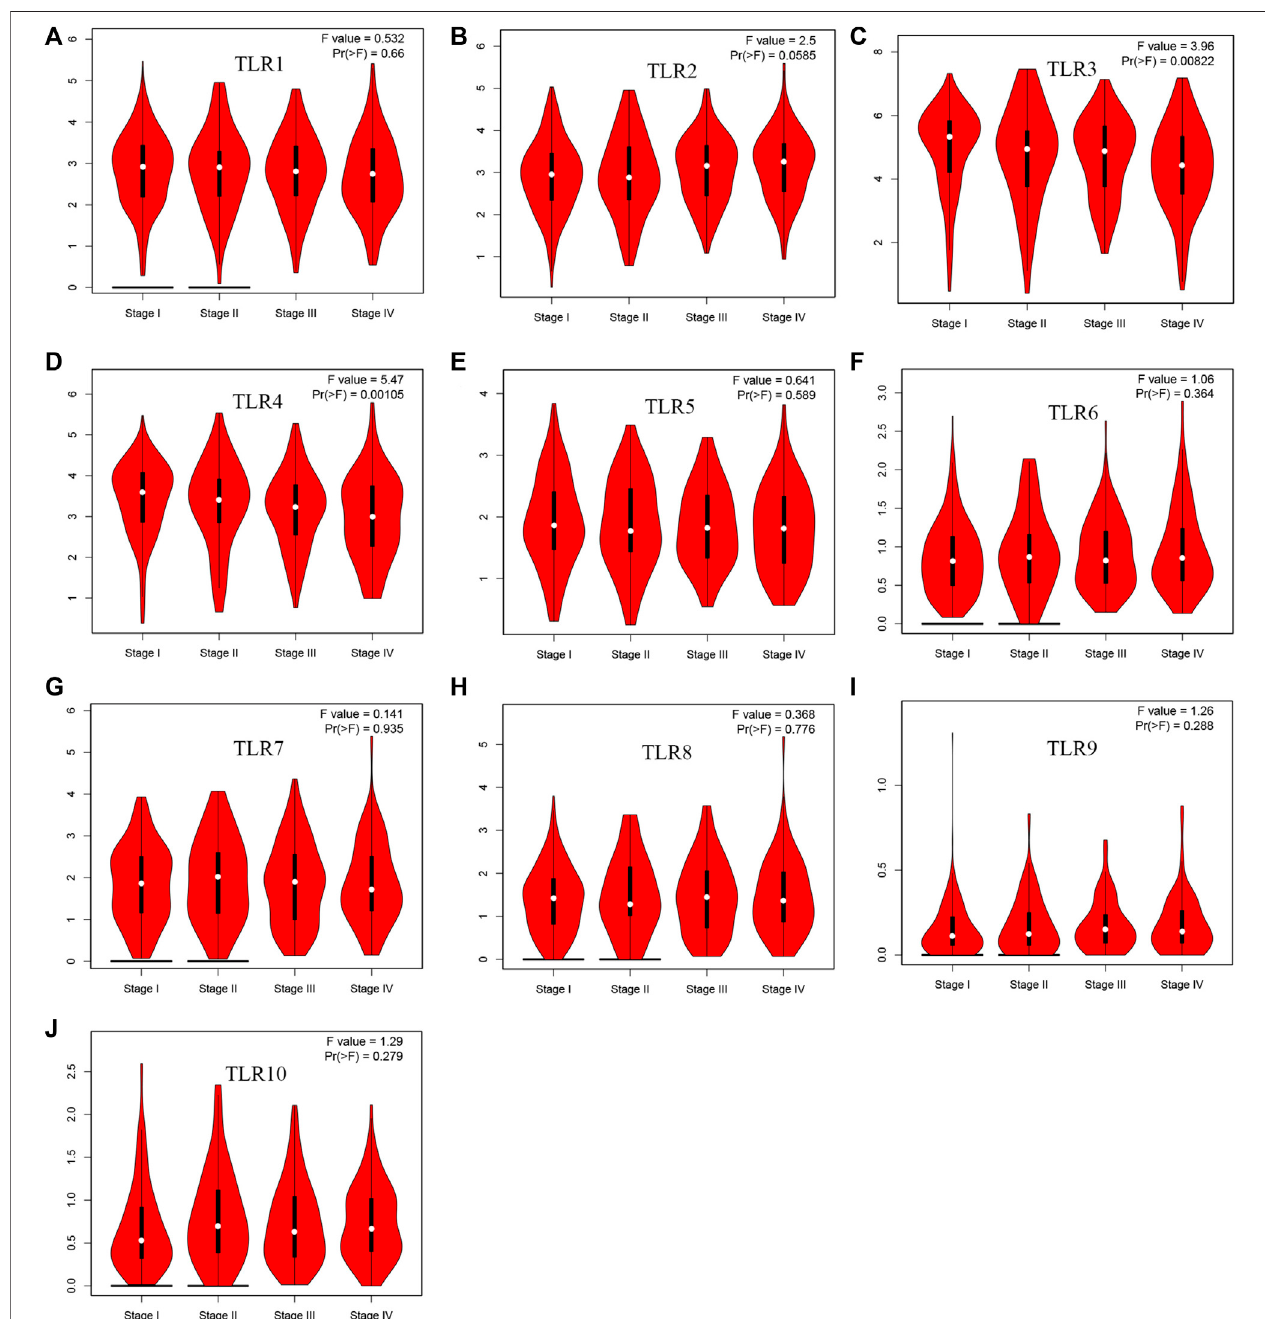
FIGURE 4| The association of TLRs expression levels with different pathological stages ofKIRC. (A) TLR1, (B) TLR2, (C) TLR3, (D) TLR4, (E) TLR5, (F) TLR6, (G) TLR7, (H) TLR8, (I) TLR9, (J) TLR10.